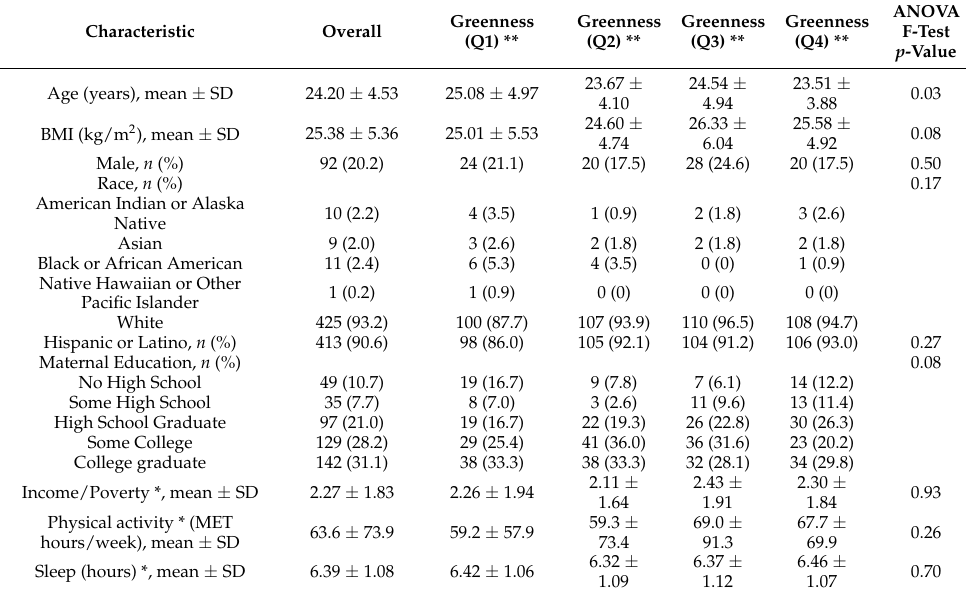
Table 1. Demographic characteristics of the Nurse Engagement and Wellness Study (NEWS) analyti- cal sample in the current study ( n =